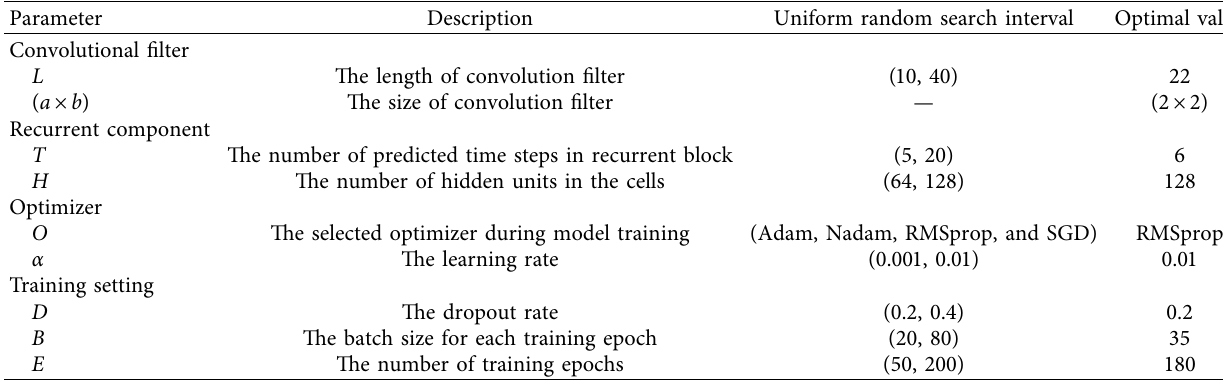
Table 2: Parameter settings in the model construction.